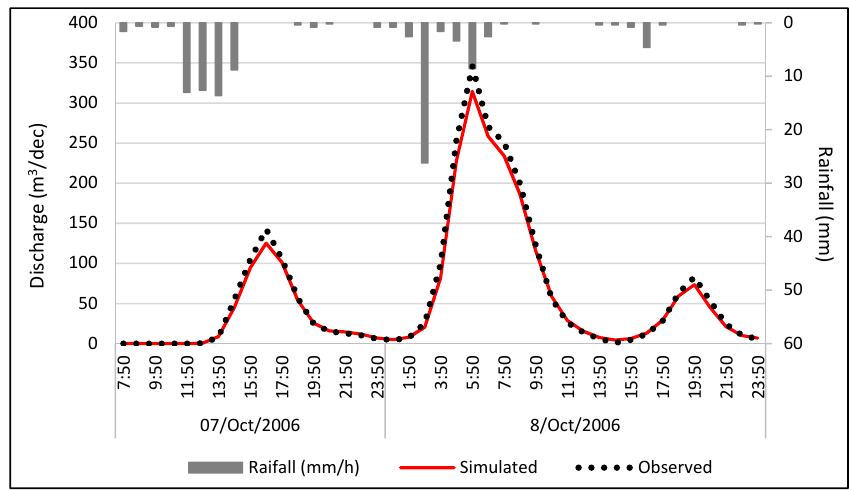
Figure 12. Observed and simulated (after the model calibration) hydrographs for the October 2006 flood event at Vatonias stream. Hydrology 2020 , 7 , x FOR PEER REVIEW